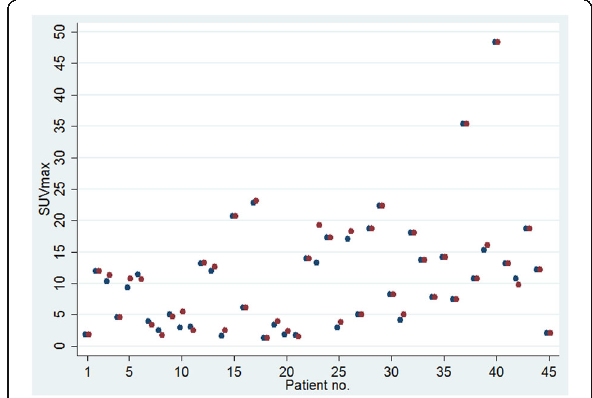
Fig. 1 Scatterplot of repeated SUVmax measurements of 60-min scans for 45 patients (blue: 1st reading, red: 2nd